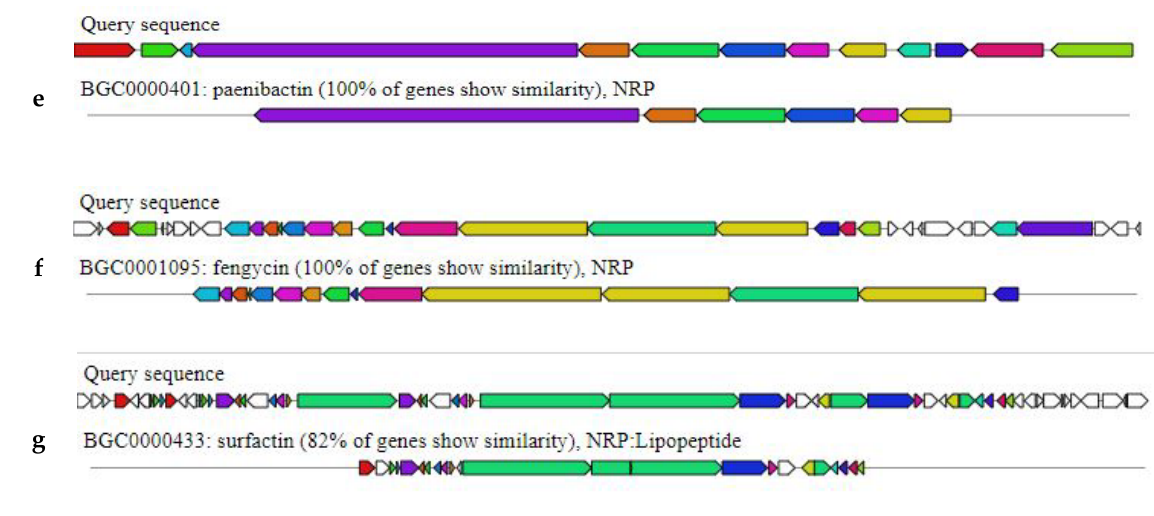
Figure 4. Secondary metabolites’ gene clusters with antimicrobial metabolites in Bacillus subtilis Bbv57, identified by antiSMASH 6.0 ( a ) Bacillibactin, ( b ) bacilysin, ( c ) subtilosin A, ( d ) fengycin, ( e ) piplastin, ( f ) paenibactin, and ( g ) surfactin. A functional categorization by gene ontology (GO) terms was performed based on the Blastx hits from the nr database using Blast 2 GO annotation in OmicsBox 2.0.10. Twenty GO terms belonging to biological processes, 7 GO terms belonging to cellular components, and 10 GO terms belonging to molecular function classes were identified (Figure 5).